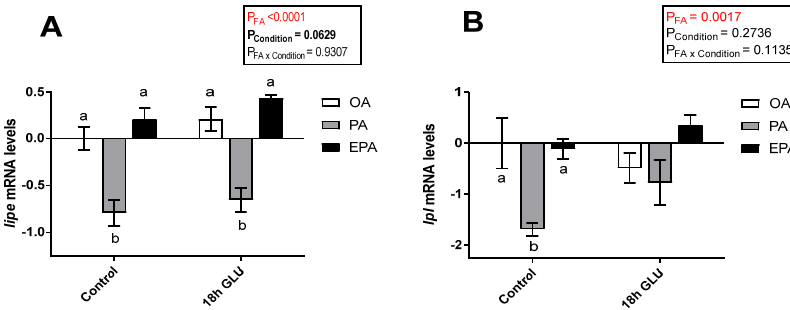
Figure 5. Relative changes in transcript levels of hormone-sensitive lipase ( lipe ) ( A ) and lipoprotein lipase ( lpl ) ( B ) in matured Atlantic salmon adipocytes incubated with oleic, palmitic, or eicosapentaenoic acid for 72 h (Control) and serum-deprived in the presence of glucagon thereafter for 18 h (18 h GLU). Samples ( n = 4) were analyzed with real-time qPCR; data are presented as − ∆∆ Ct ± SEM, and the OA group from the Control condition was set to zero. Results are compared by two-way ANOVA using the fatty acid tested (OA, PA, and EPA) and the experimental condition (Control and 18 h GLU) as factors. Lowercase letters indicate significant di ff erences between fatty acids ( p < 0.05; Tukey’s post hoc test). OA = oleic acid, PA = palmitic acid, and EPA = eicosapentaenoic acid.